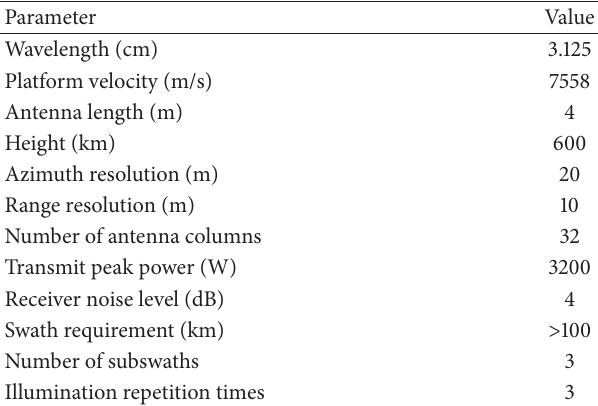
Figure 2: Diamond diagram showing the setting of PRF. Table 1: The basic system parameters and the system